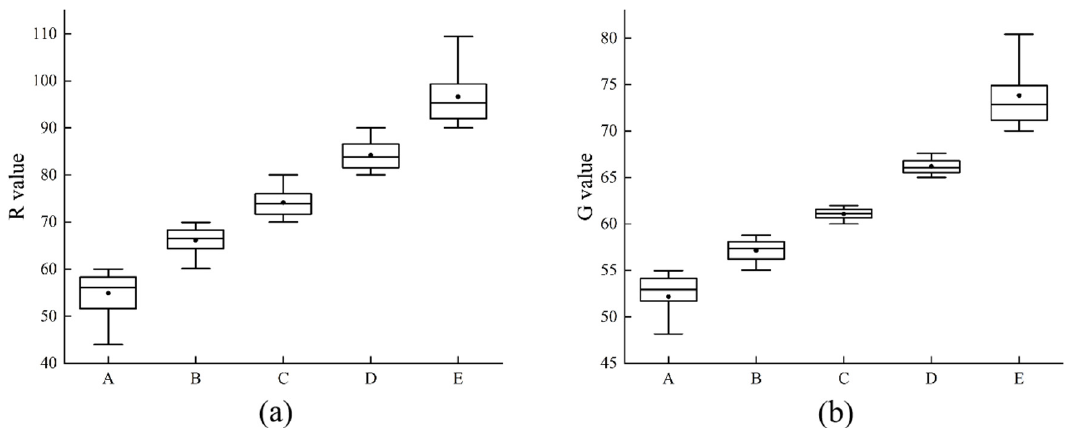
Figure 9. Box plot between R values ( a ) and G values ( b ) of different groups and their corresponding high-quality seed percentage. ( a ) A: A seed population with 95.0 ± 1.0% high-quality seed percentage; ( a ) B: A seed population with 94.3 ± 2.3% high-quality seed percentage; ( a ) C: A seed population with 91.7 ± 2.5% high-quality seed percentage; ( a ) D: A seed population with 73.7 ± 0.6% high-quality seed percentage; ( a ) E: A seed population with 37.7 ± 15.0% high-quality seed percentage; ( b ) A: A seed population with 98.3 ± 2.1% high-quality seed percentage; ( b ) B: A seed population with 94.7 ± 0.6% high-quality seed percentage; ( b ) C: A seed population with 94.7 ± 1.2% high-quality seed percentage; ( b ) D: A seed population with 92.7 ± 1.2% high-quality seed percentage; ( b ) E: A seed population with 81.0 ± 2.6% high-quality seed percentage.